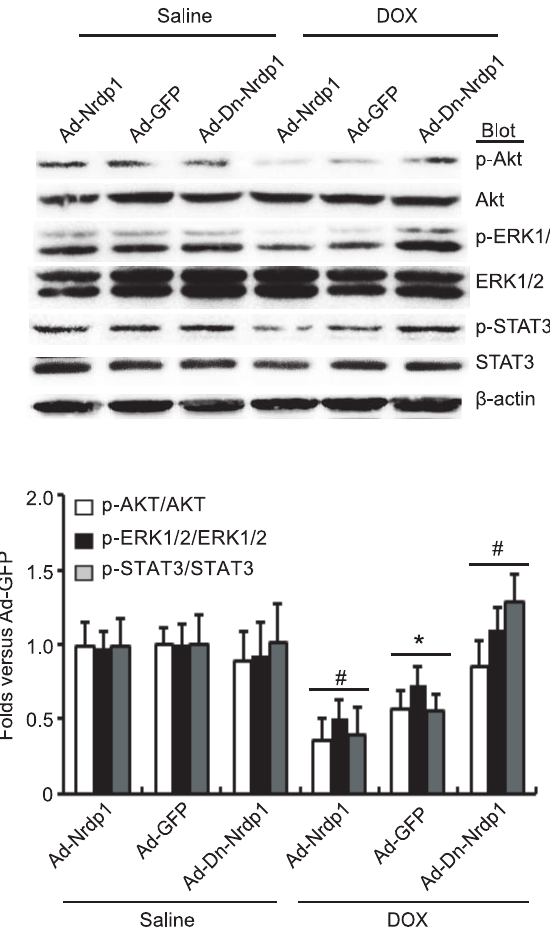
Figure 8. Effect of Nrdp1 on the phosphorylation of Akt, ERK1/2 and STAT3 in rat neonatal cardiomyocytes. Rat neonatal cardiomyocytes were infected by with Ad-GFP, Ad- Nrdp1 or Ad-Dn- Nrdp1 and then treated with 0.5 m M DOX for 24 hr. Western blot analysis of protein levels of phosphorylated and total Akt, ERK1/2 and STAT3 (n=4 per group, top panels). b -actin was used as a loading control. A representative blot is shown for each condition. Quantitative analysis is in the bottom panel. * P , 0.05 vs. Ad-GFP + saline; # P , 0.05 vs. Ad-GFP + DOX.